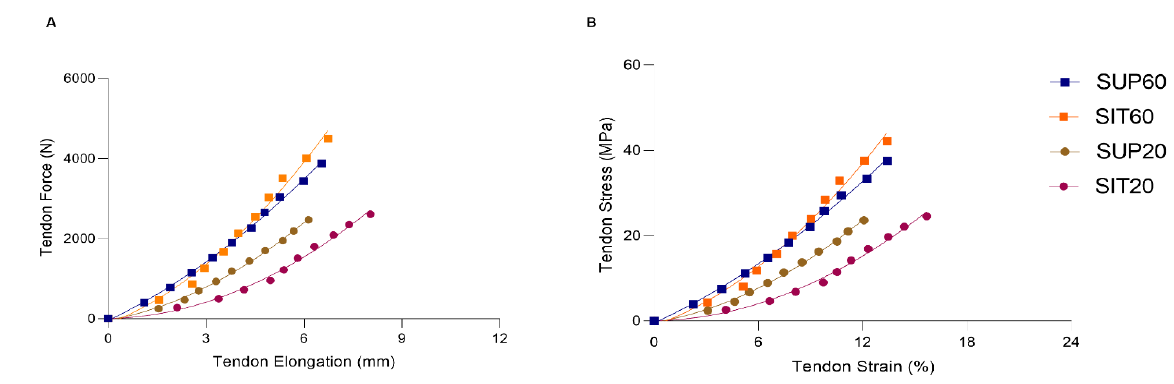
Figure 6. The patellar tendon force-elongation ( A ) and stress-strain ( B ) relationships according to hip and knee angles during MVIC. SUP60 (closed square blue line); SIT60 (closed square green line); SUP20 (closed circle red line) and SIT20 (closed circle purple line). Data are presented as mean (SD). Legend: SUP60: supine with 60 ◦ of knee flexion; SIT60: seated with 60 ◦ of knee flexion; SUP20: supine with 20 ◦ of knee flexion; SIT20: seated with 20 ◦ of knee flexion.